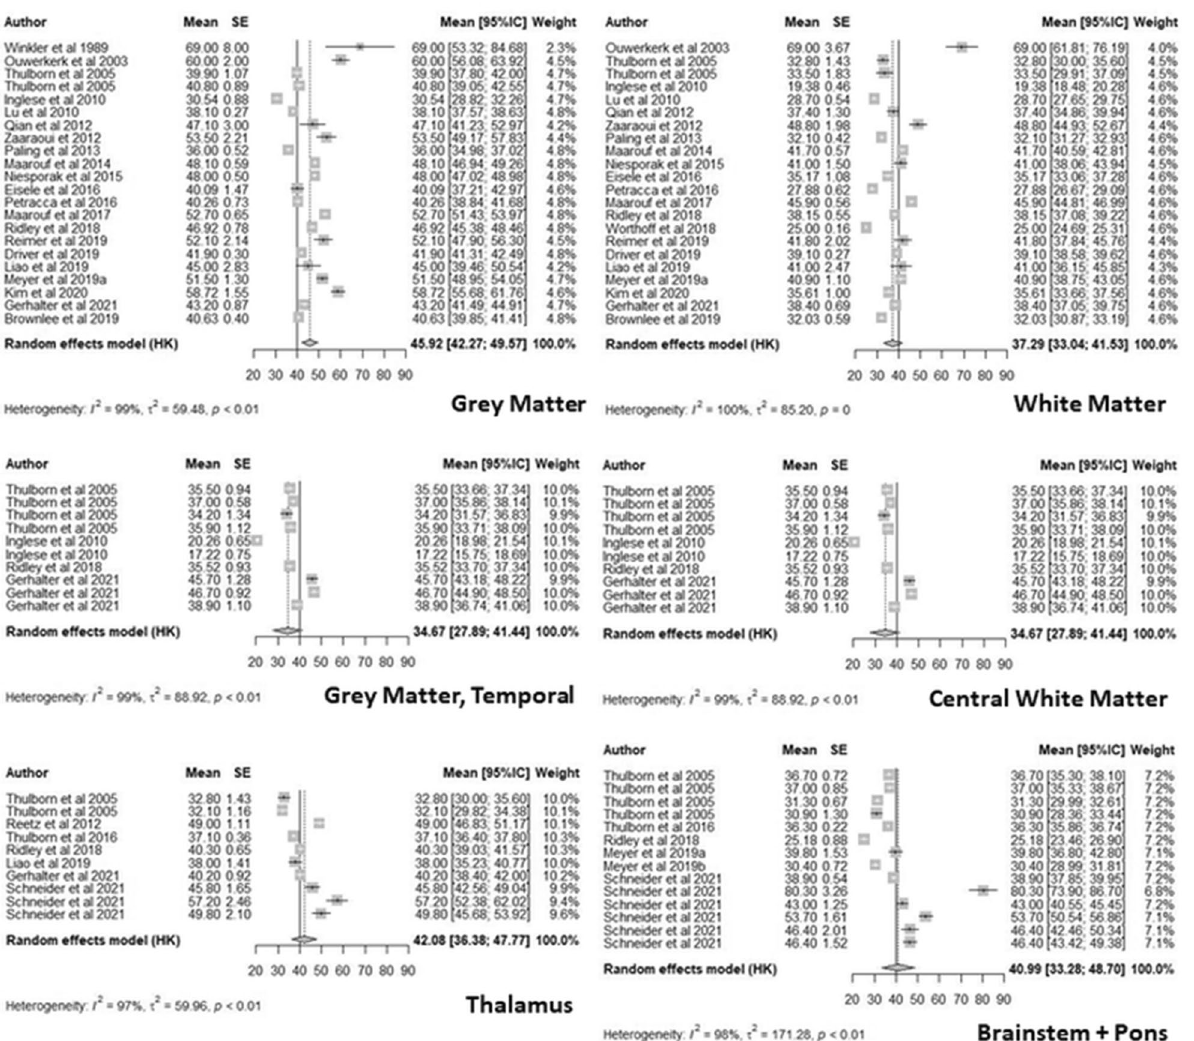
Figure 4. Forest plots for anatomical regions with at least ten effect sizes: grey matter; Temporal grey matter; thalamus; white matter; central white matter; brainstem + pons. Each forest plot contains the effect size data, represented by grey squares scaled to their weight in the meta-analytic model and error bars corresponding to 95% confidence intervals. The regional pooled estimate for each plot is represented by a grey diamond scaled in length to the confidence interval of the pooled estimates, and a dotted reference line. The pooled overall mean of all 141 included effect sizes is represented by a solid reference line on each plot. Plots generated in R, in the metafor package 74